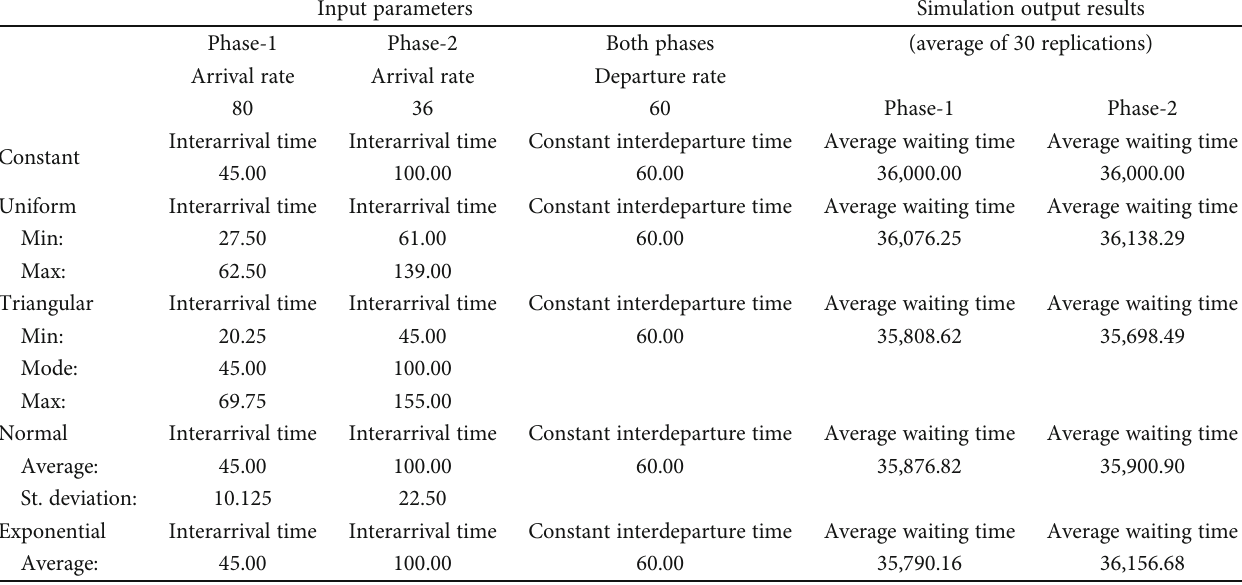
Table 3: Comparison of the average waiting times in phase-1 and phase-2 for four di ff erent interarrival time distributions: uniform, triangular, normal, and exponential. Constant rate refers to deterministic interarrivals. Mean interarrival rates for all distributions in phase-2 are 100